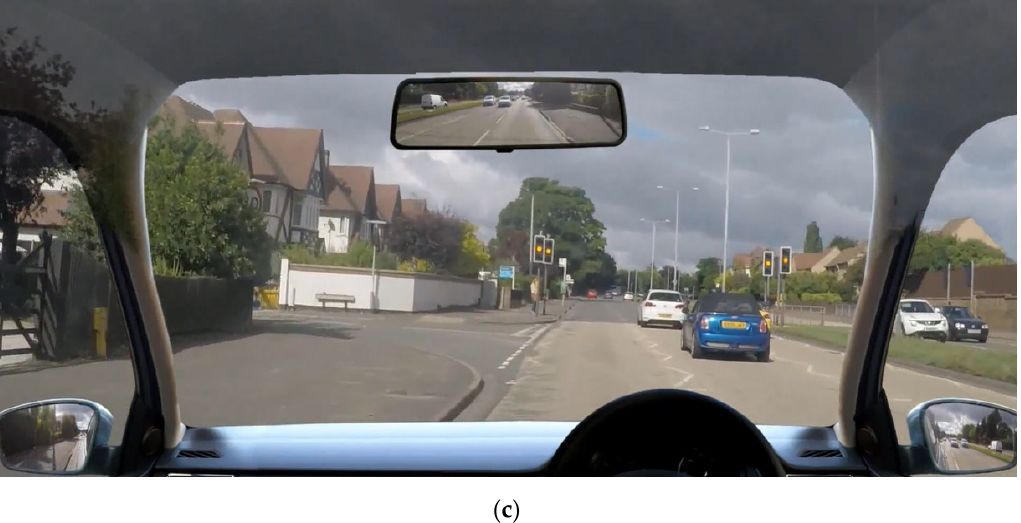
Figure 1. Screenshots of the final frame (prior to occlusion) of the selected risky situation: ( a ) The top panel depicts a situation with a cyclist on the left. The cyclist is further out from the camera car with oncoming traffic. The overtaking manoeuvre is considered not to be safe due to the oncoming traffic and poor visibility of the road ahead. ( b ) The middle panel shows a situation with a bus in front of the camera car. The overtaking manoeuvre is considered not to be safe, as markings in the middle should not be entered with such poor visibility of the road ahead (with red area to increase awareness of potential danger and road arrows indicating that the two lanes are about to merge in one lane). ( c ) The bottom panel depicts a situation with lights in amber. Passing through the amber lights is not safe, as the distance the camera car is travelling at will not reach the traffic lights before those turning red. The risk is greater for the pedestrian, visible on the left, who could be about to step into the road.